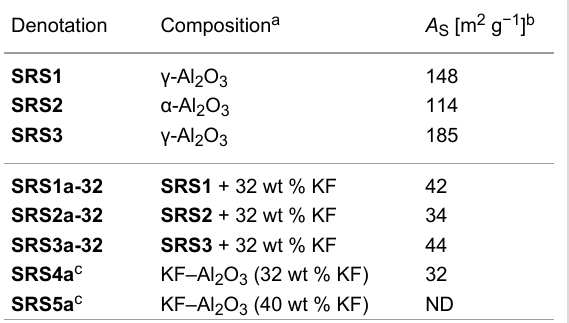
Table 2: Characteristics of the base components applied in Suzuki–Miyaura reactions as SRS .